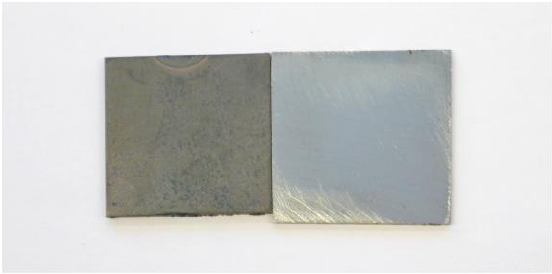
Figure 31. Comparing treated (left) and untreated (right) C15 steel samples at t = 4 h, P screen = 90 W, φ = 20 sccm (H 2 :N 2 = 1:1), p = 3 mbar, and T samples = 823 K [63], Reproduced from [63], with the permission of AIP Publishing.